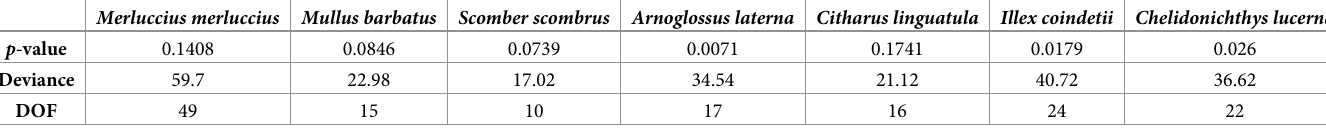
Table 4. Fit statistics of the combined model used in the catch comparison between the 40 mm square mesh codend and 50 mm diamond mesh codend. DOF: degrees of freedom. Merluccius merluccius Mullus barbatus Scomber scombrus Arnoglossus laterna Citharus linguatula Illex coindetii Chelidonichthys